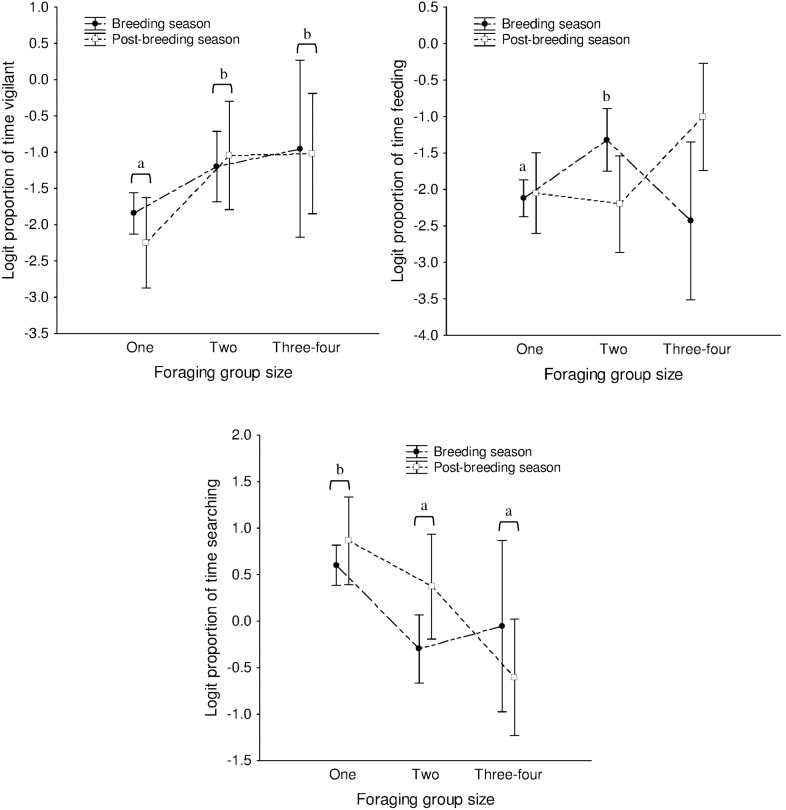
Time spent in different activities while foraging in groups of different sizes.Logit transformed proportions of time spent in feeding, vigilance, and searching by single birds, paired birds, and groups of 3–4 birds during the breeding and post-breeding seasons. Significant pairwise, post-hoc comparisons following a significant effect in the ANOVA are marked with letters (a<b). The horizontal brackets indicate that both breeding and post-breeding seasons have been taken together for the comparison (error bars are 95% CIs about the individual means).